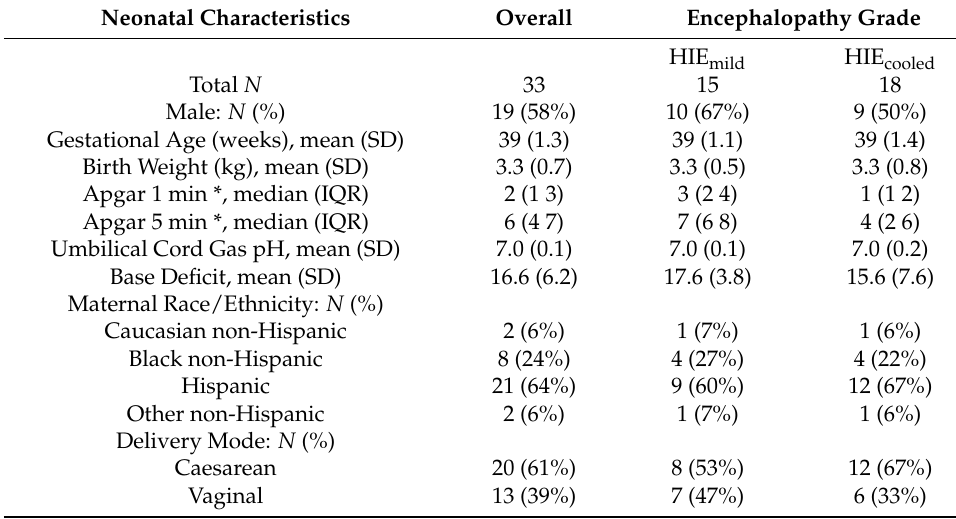
Table 1. Characteristics of the neonatal